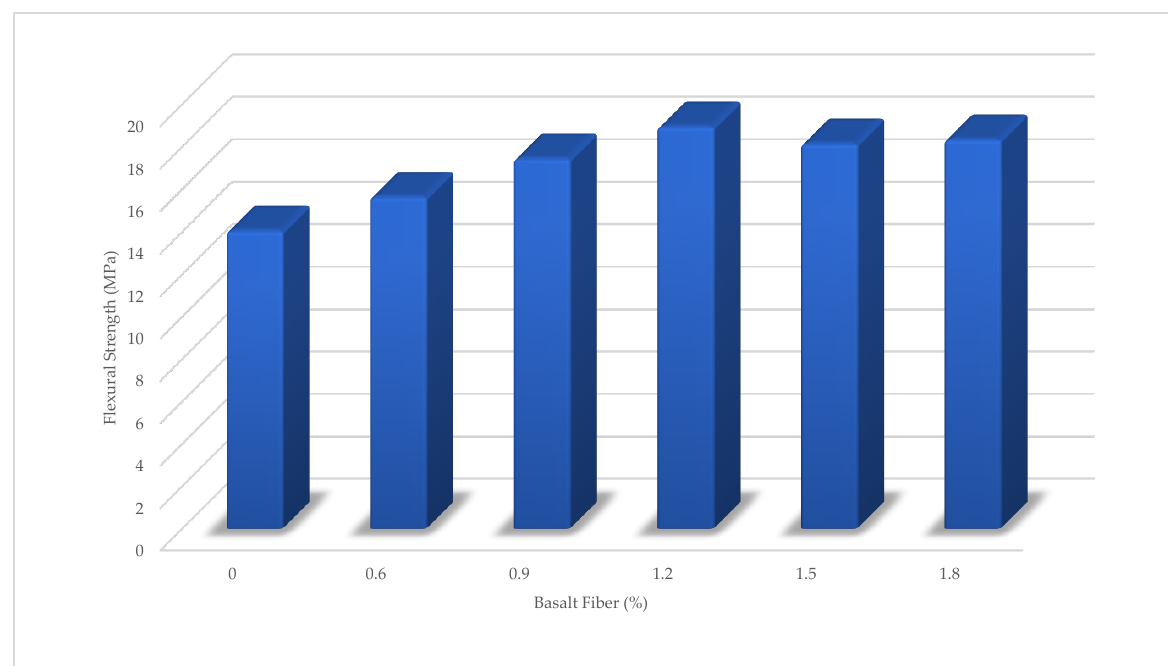
Figure 14. Flexural Strength of BFHPC with different BF Percentages.